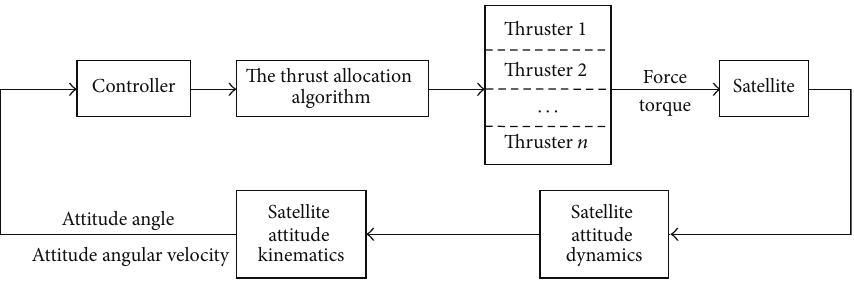
Figure 1: The principle diagram of thrust